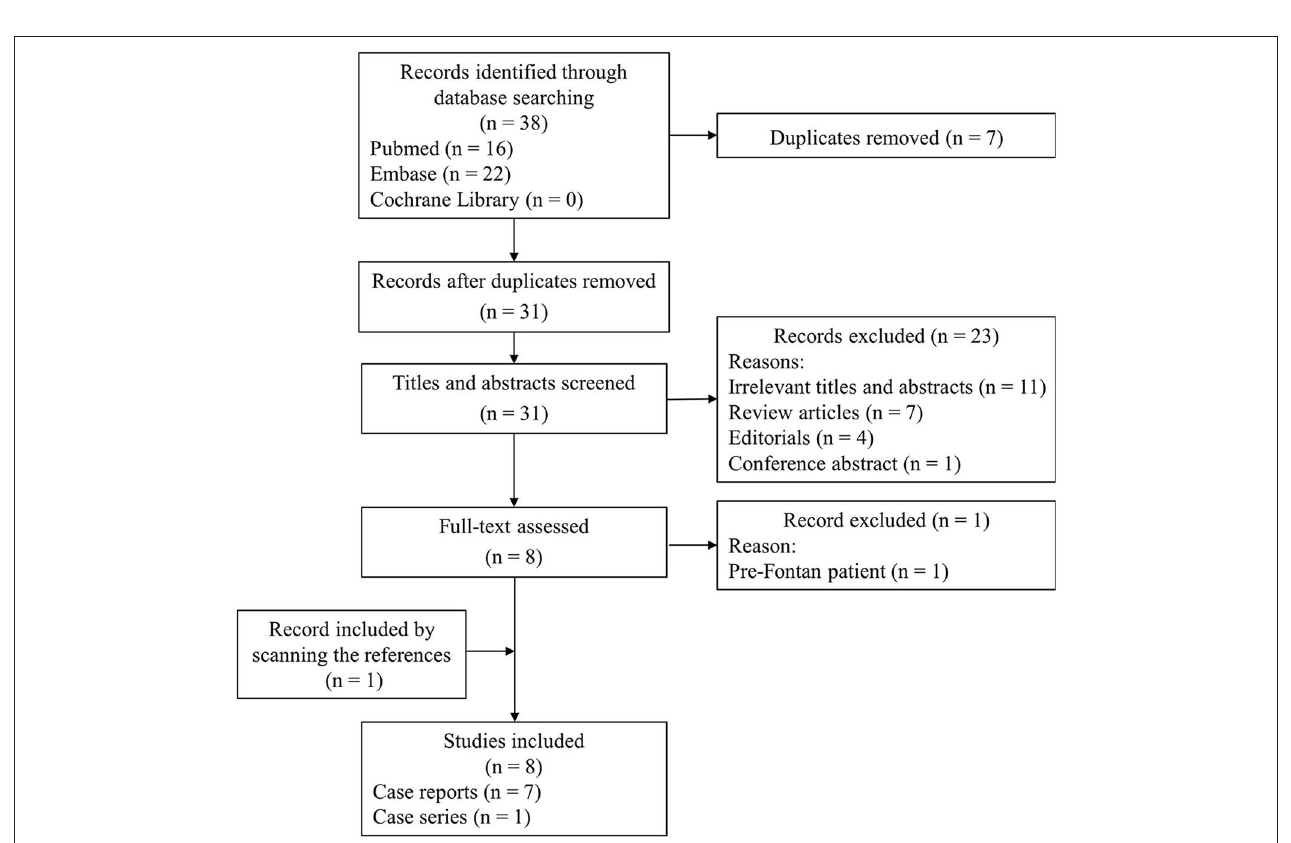
FIGURE 3 | The flow chart of the literature screening process for patients with COVID-19 and Fontan palliation.